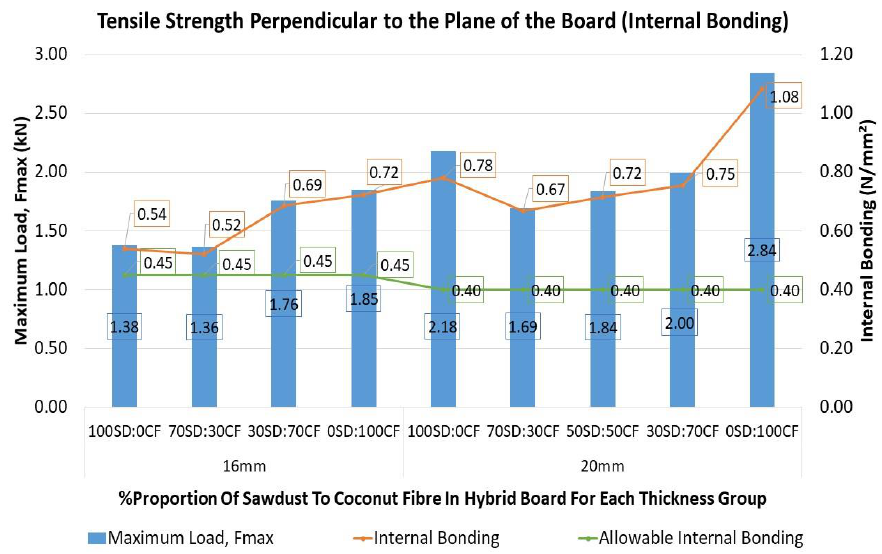
Figure 18. Tensile Strength Perpendicular to the Plane of the Board (Internal Bonding) .